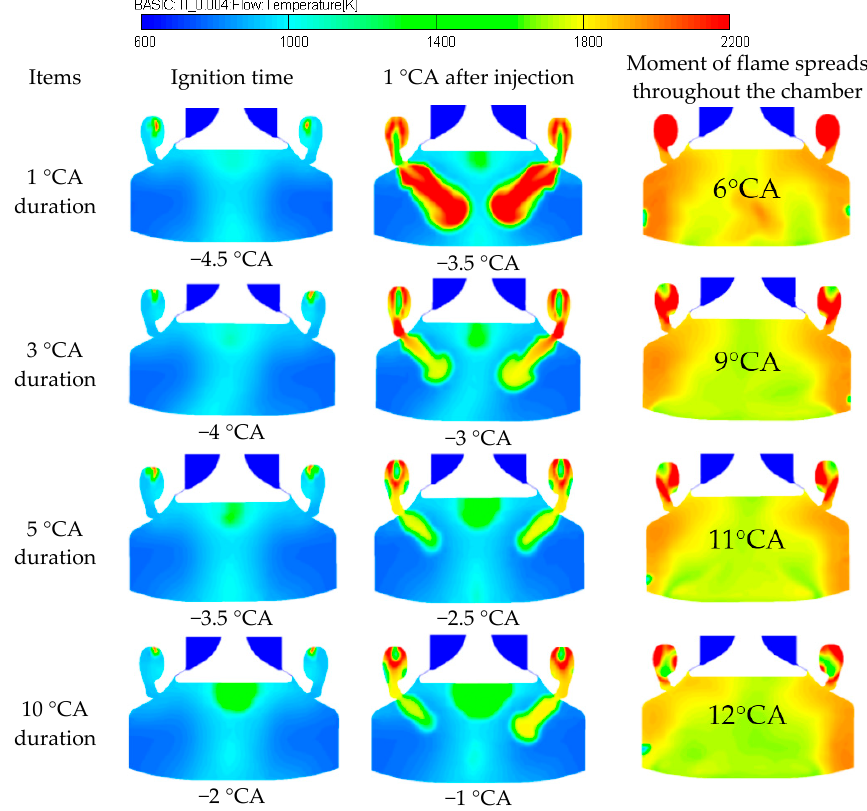
Figure 18. Temperature distribution in the combustion chamber.